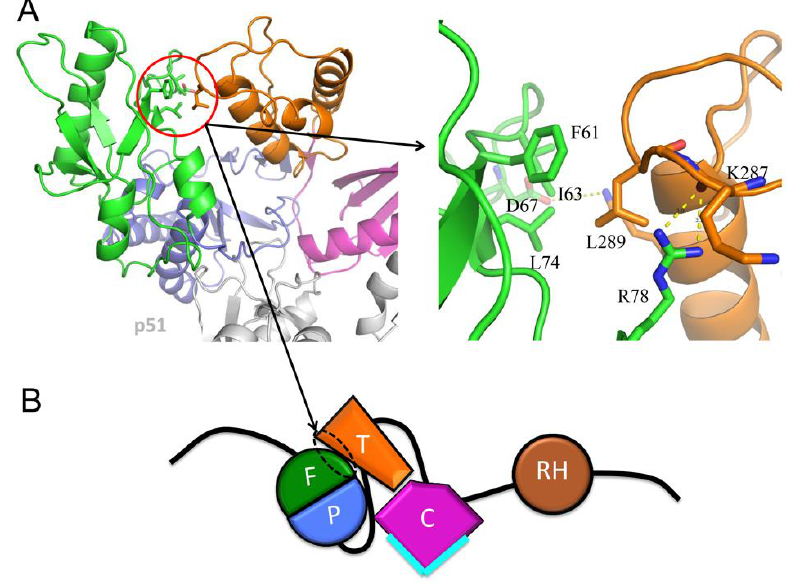
Figure 7. The fingers:thumb interface in apo RT. ( A ) Ribbon diagram showing Leu289 and other residues at the fingers:thumb interface in the p66 subunit of apo RT (PDB ID: 1DLO) ( left ), and expanded view of interface interactions ( right ); ( B ) Schematic illustration of the domain organization facilitated by the formation of the fingers:thumb interface during the maturation process. Domains are color coded as in Figures 2 and